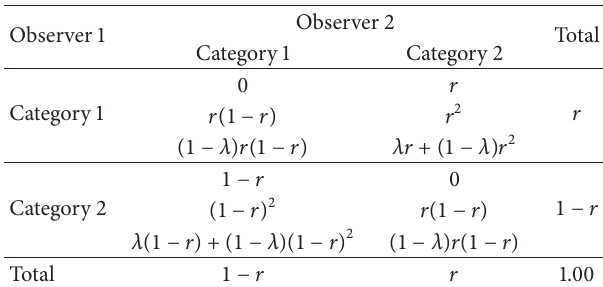
Table 1: A 2 × 2 contingency table with marginal probabilities r and 1 − 𝑟 and with the entries in each cell as follows: first entry corresponds to 𝑃 AD = 0 , second entry corresponds to 𝑃 AO = 𝑃 AC , and third entry is the weighted mean of the other two entries where 0 ≤ 𝜆 ≤ 1 .